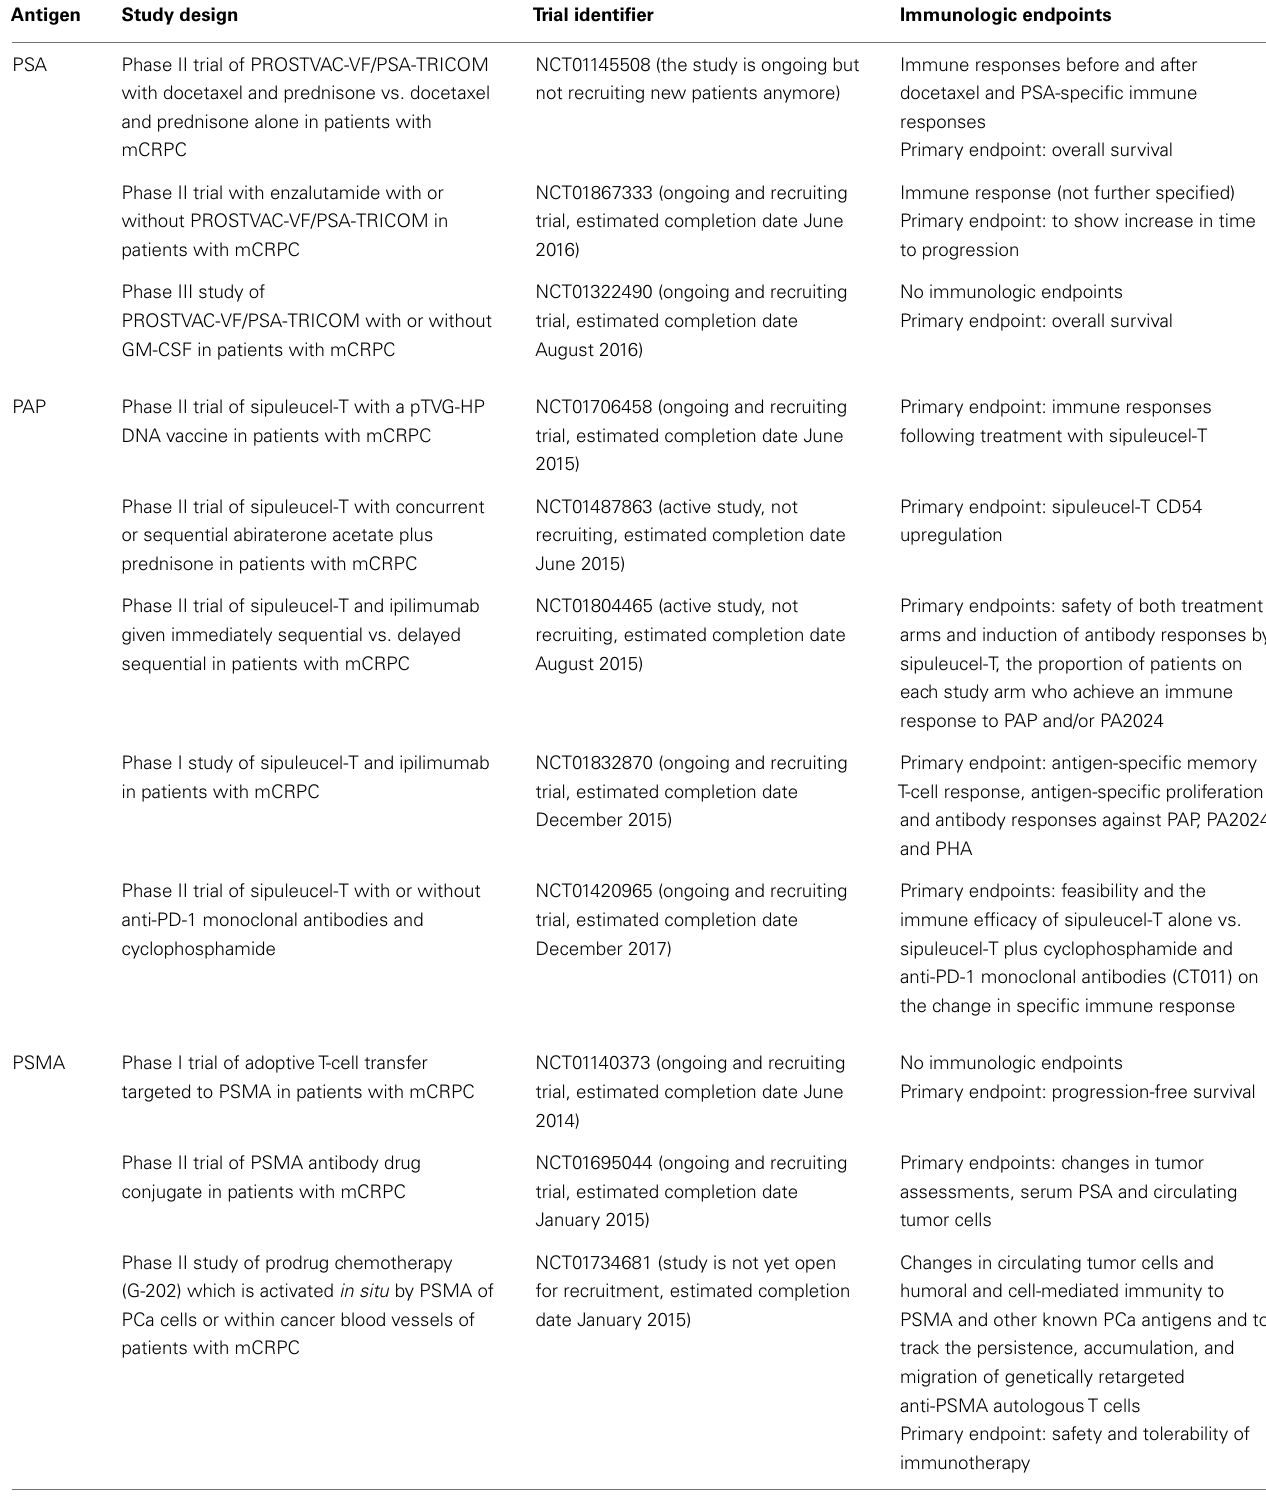
Table 2 | Ongoing trials encompassing antigen-based immunotherapy